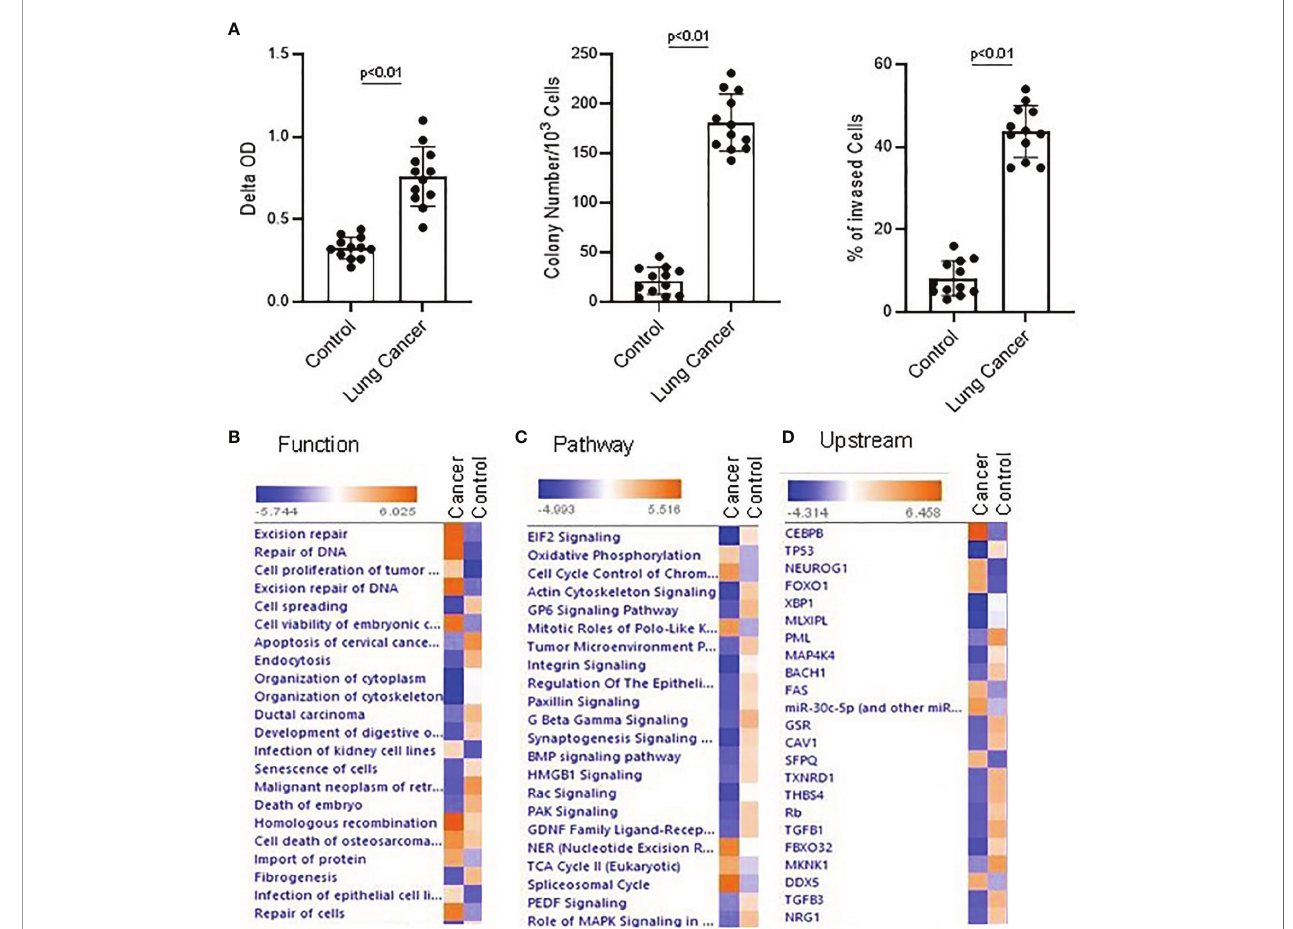
FIGURE 1 | Proteomics and Ingenuity pathway analysis with lung NSC cancer and control MSC nuclear Pro fi le. (A) Colony formation, cell proliferation and invasion assay were conducted with the normal and lung cancer MSCs. Lung NSC cancer MSCs have higher capability of proliferation(Left panel), colony forming (middle) and invasion (Right panel) than that of normal MSC cells. 4 normal lung cell lines (C210, C205, C215, C249) and 4 lung NSC cancer cell lines (Can661, Can522, Can838, A549) were used in these experiments. All data are shown as mean ± S.E. ( n =3 independent experiments). (B – D) Proteins identi fi ed from control and lung NSC cancer MSC nuclear fraction with relative quanti fi cation in Proteomics analysis were applied to IPA to generate the biological networks from Lung cancer MSC and control MSCs dataset. (B) Top cell functions associated with the differentially expressed genes. (C) Top upstream regulators associated with different proteins. (D) Top canonical pathways associated with different proteins. Cell functions, upstream regulators or pathways identi fi ed are represented on the y-axis. The x-axis corresponds to the – log of the P-value (Fisher ’ s exact test) and the orange points on each pathway bar represent the ratio of the number of proteins in a given pathway that meet the cutoff criteria, divided by the total number of proteins that map to that